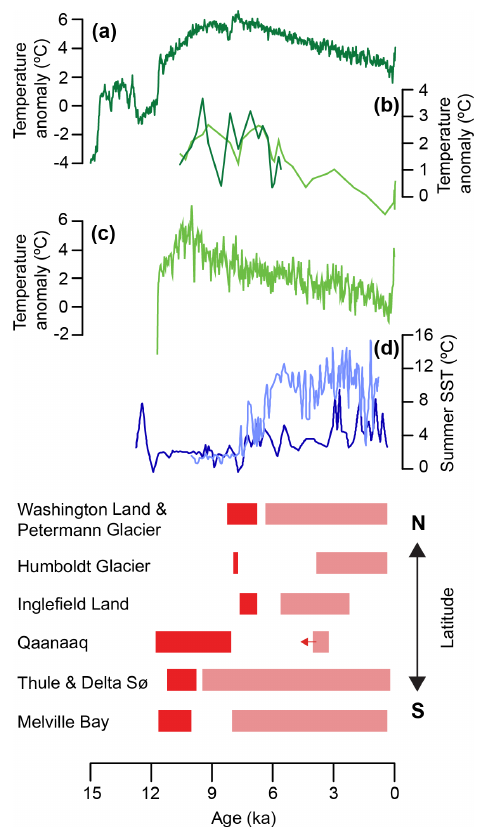
Figure 9. Ice extent and climate fluctuations for north and north- west Greenland during the last 15kyr. (a) Mean annual tempera- ture anomalies, northwest Greenland (Buizert et al., 2018). (b) July air temperature anomalies at Delta Sø, northwest Greenland, us- ing two different training sets and transfer functions, FOR15 (light green) and FRA06 (dark green) (Axford et al., 2019). (c) Agassiz δ 18 O temperature reconstruction (Lecavalier et al., 2017). (d) Re- constructed west Greenland sea surface temperatures from Gibb et al. (2015) (dark blue) and Ouellet-Bernier et al. (2014) (light blue). Panel (e) shows the inferred ice extent in north and north- west Greenland from Melville Bay in the south to Washington Land in the north (for references, see text). Dark red bars denote known periods of deglaciation from the outer coast towards the present- day ice margin and bright red bars denote periods of smaller than present-day extent. Arrows indicate the lack of an upper or lower